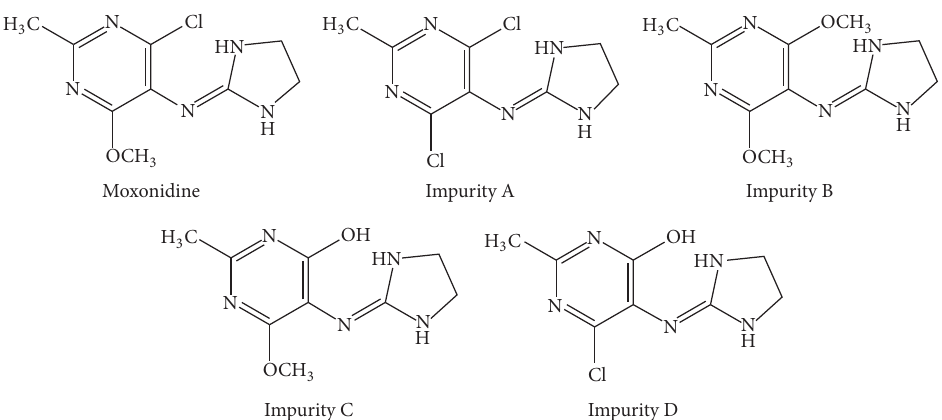
Figure 1: Chemical structures of moxonidine and its